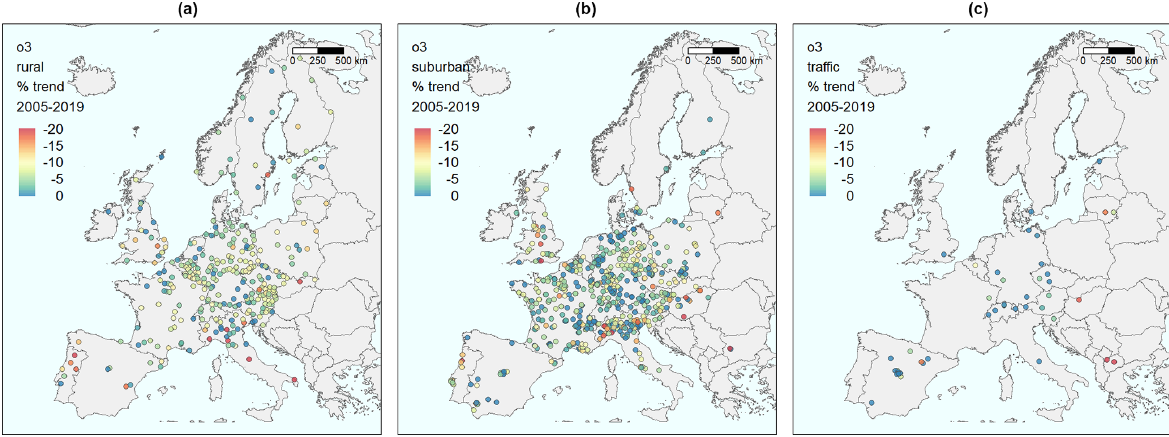
Figure 5. Maps of stations in Europe with the percentage change in expected concentrations from 2005 to 2019, relative to the initial level in 2005, based on the meteorology-adjusted trend for O 3 . (a) Background stations in rural areas. (b) Background stations in urban/suburban areas. (c) Traffic stations.